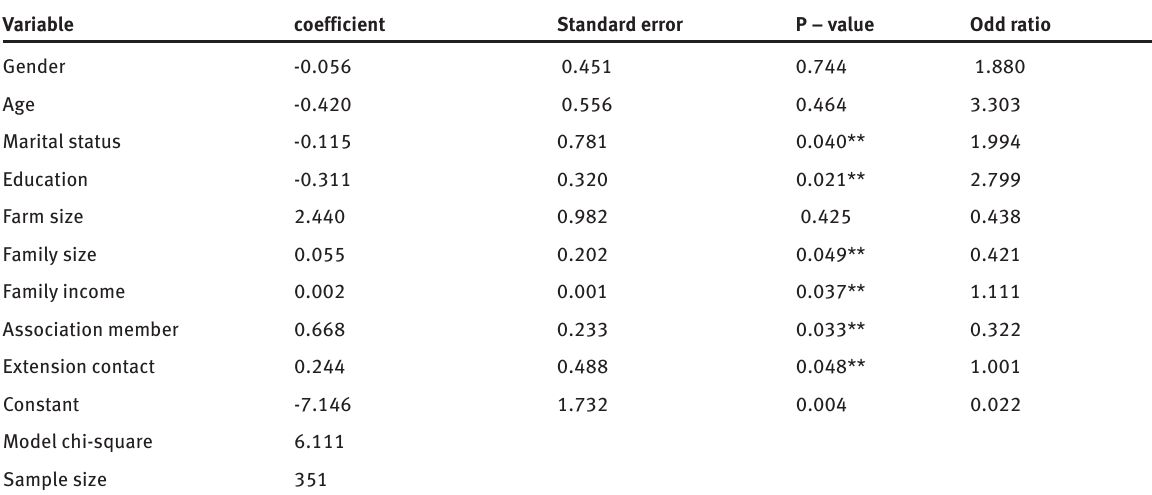
Table 7: Rural folks’ perception of socio-economic variables associated with suicide